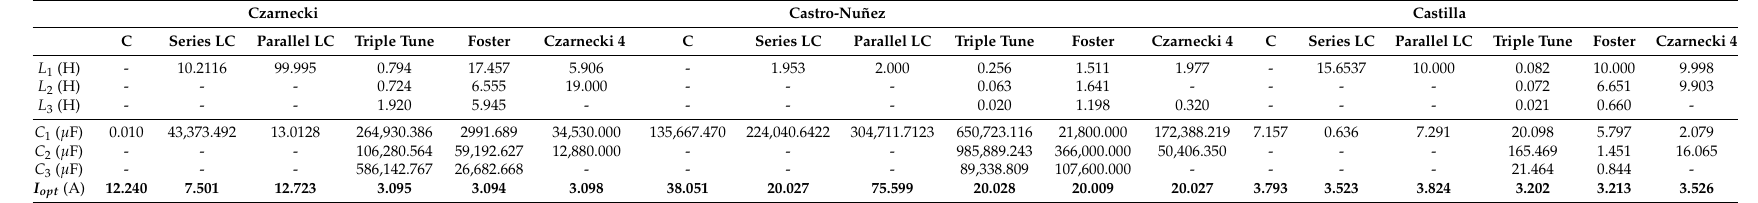
Table 4. Optimal values for L, C achieved by the genetic algorithm for the 3 cases of study and the 6 proposed filters.